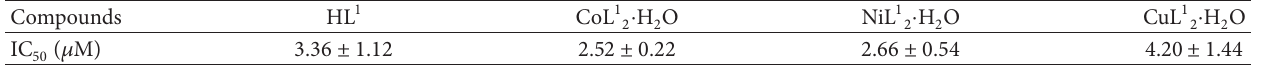
Table 8: Antiproliferative activities of investigated compounds against human cancer (HL-60) cell